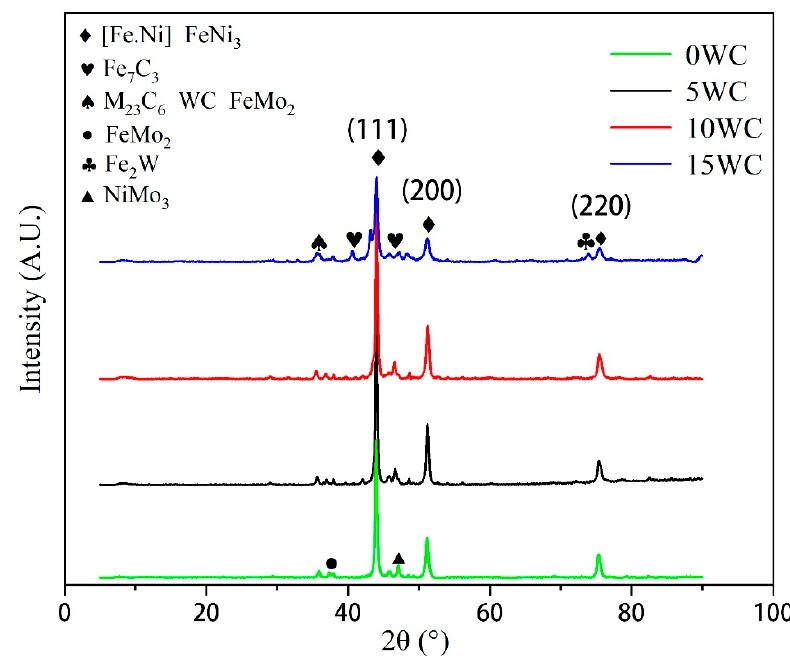
Figure 1. XRD analysis of different coatings.